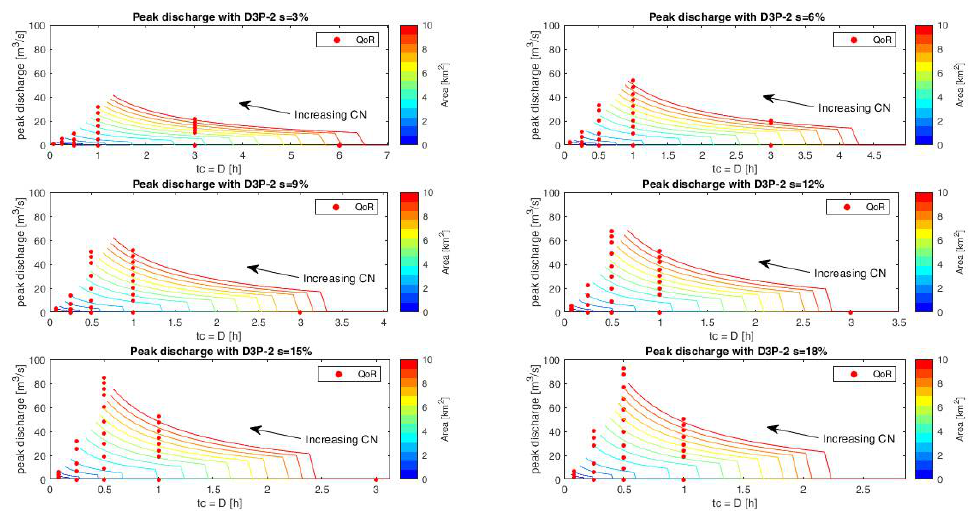
Figure 8. Peak curves obtained with D3P-1 vs. Q-Peak (red dots) evaluated with observed Rainfall.